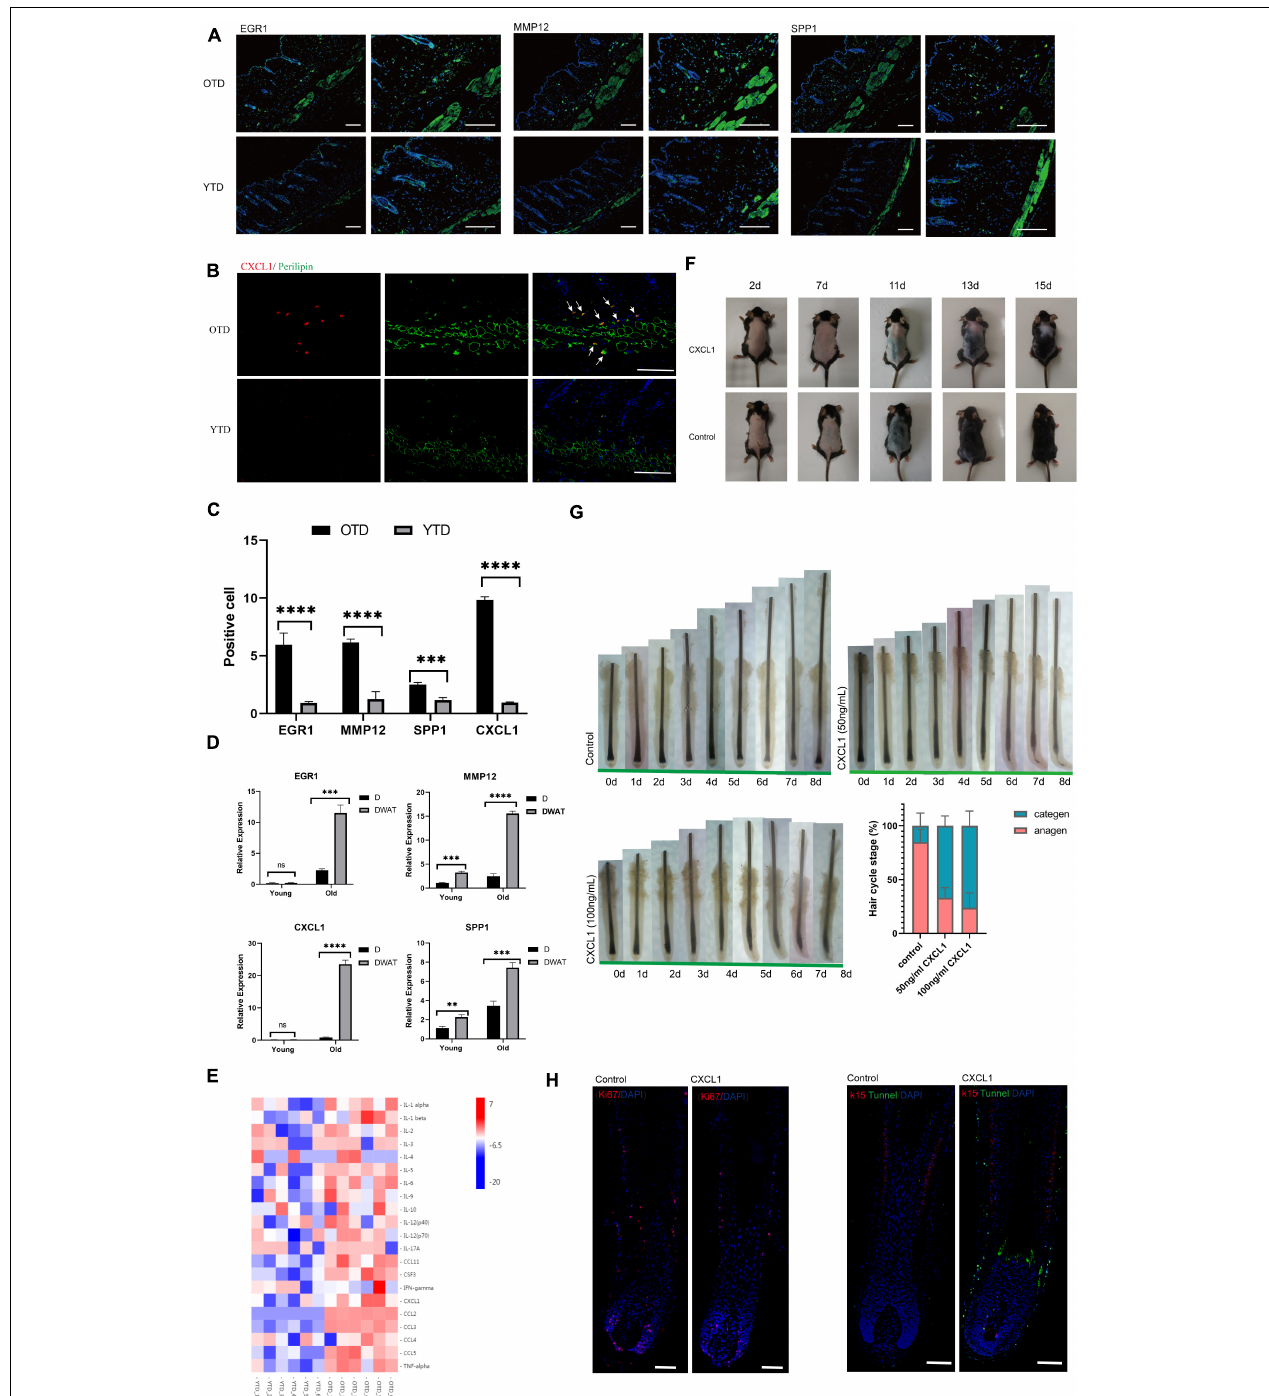
FIGURE 3 | Aberrant inflammatory infiltration in aging dWAT during telogen. (A–C) Immunostaining images showed enhanced expression of crucial inflammation regulators EGR1, CXCL1, MMP12, SPP1 in OTD. Their distribution was mainly concentrated in dWAT. CXCL1 co-located with perilipin, a marker of mature adipocytes. Scale bars = 100 µ m. (D) The relative mRNA expression level of the differential genes EGR1, CXCL1, MMP12, SPP1 in dermal tissues and dWAT. n = 8. (E) Significant upregulated protein levels of 21 inflammatory cytokines were found in OTD by a mouse cytokine/chemokine 23-plex array panel. n = 6. (F) CXCL1 injection resulted in delayed HF activation. (G) Organ culture assays of hair follicle. Human isolated hair follicles cultured with CXCL1 for 8 days in 24 well plates and histomorphometric analysis of hair follicle stages after organ cultured 4 days. Addition of CXCL1 50 and 100 ng/mL promoted hair follicle entry categen. For each experimental data point, n = 12. (H) Immunofluorescence of Day 3 cultured hair follicle showing apoptosis and decreased proliferation signaling appeared significantly in the CXCL1 group. K15, a specific marker of HFSC, was co-stained with apoptosis signal using tunnel test kit as well. Scale bars = 200 µ m. ** P < 0.01, *** P < 0.001, and **** P < 0.0001.